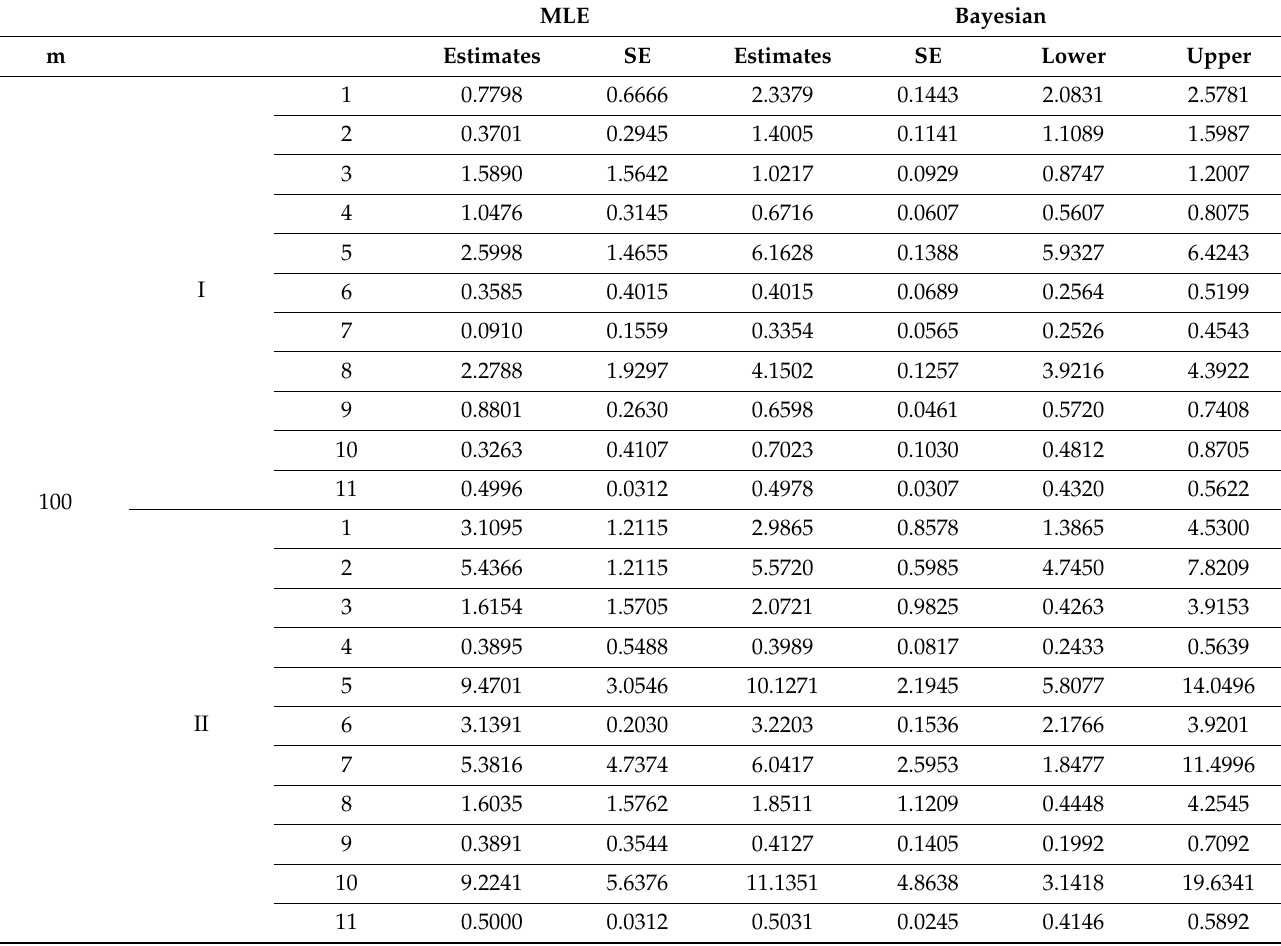
Figure 7. MCMC density and HDI intervals for the Bayesian estimation of model for complete Bladder data for the last two parameters. Table 10. ML estimates of the MEKW parameters for different censoring schemes of the bladder